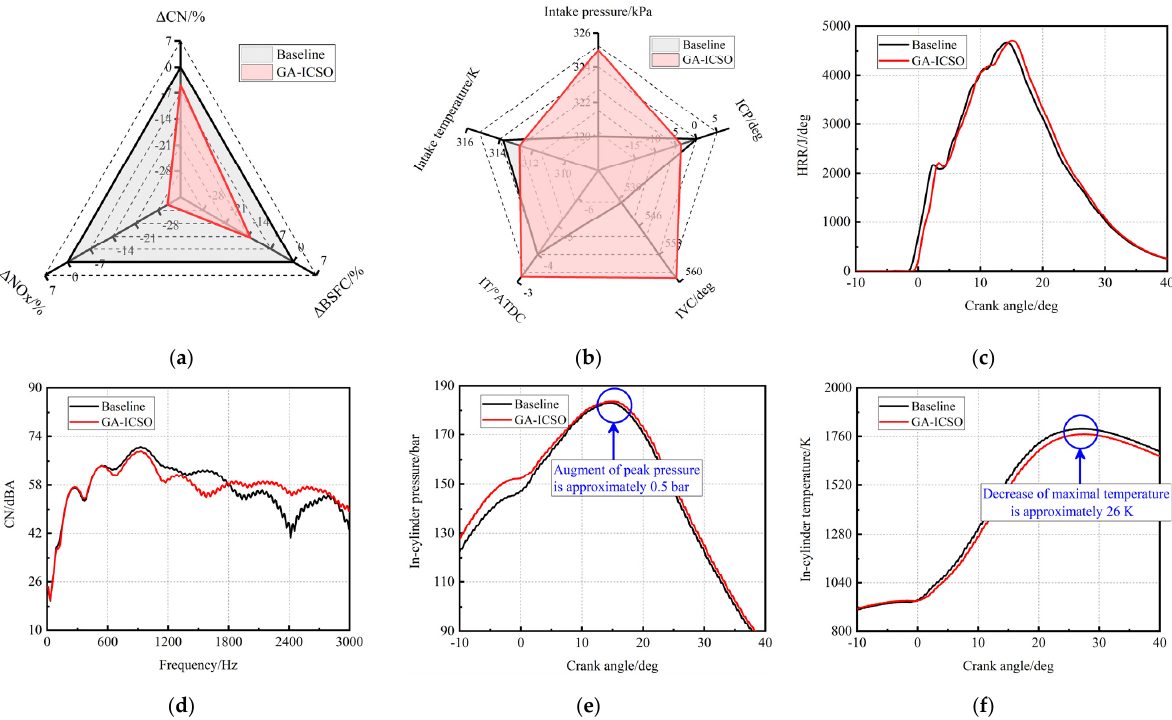
Figure 17. Comparisons between optimization results and baseline for the condition of 75% load: ( a ) Optimization percentage convergence; ( b ) Engine control variables; ( c ) HRR; ( d ) Combustion noise spectrum; ( e ) In-cylinder pressure; ( f ) In-cylinder temperature.